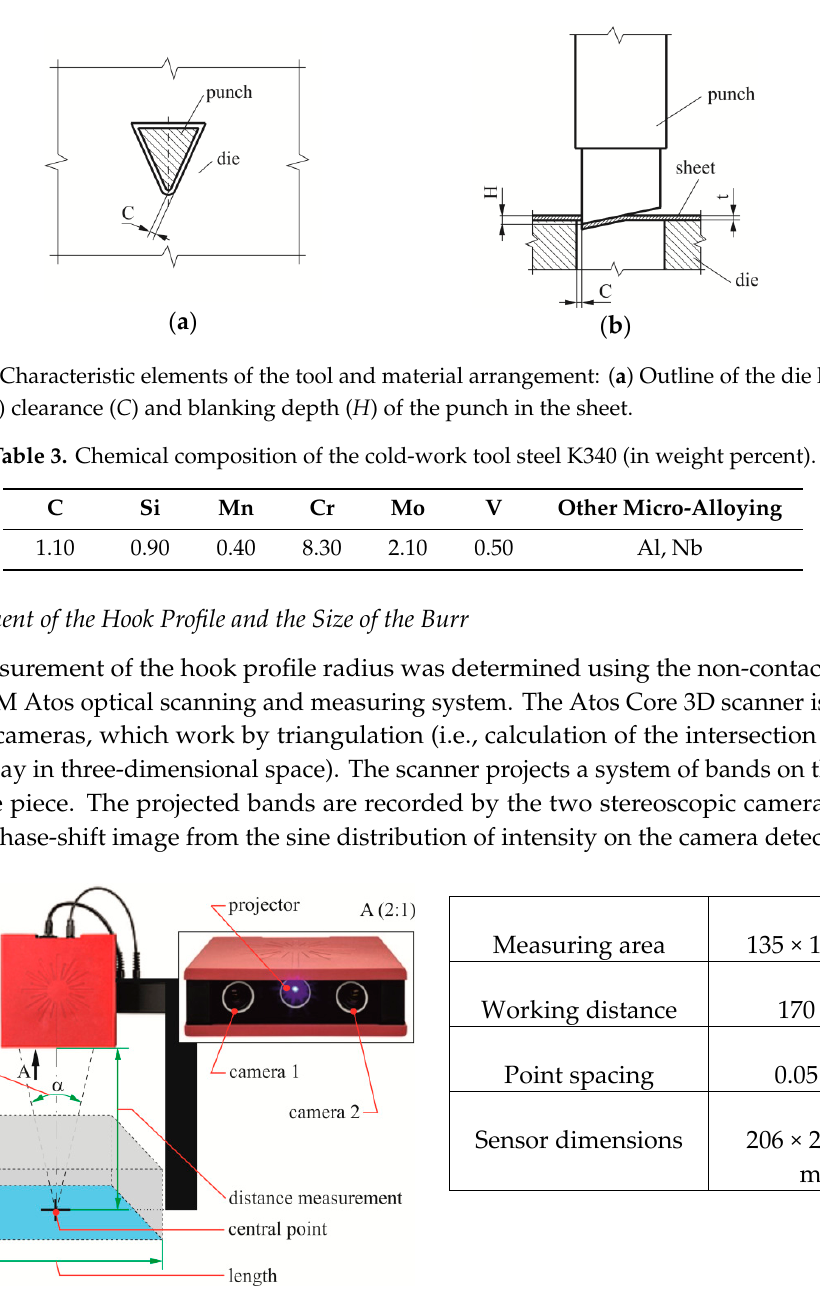
Figure 5. Idea of the AtosCore 135 measurement system and main camera parameters.